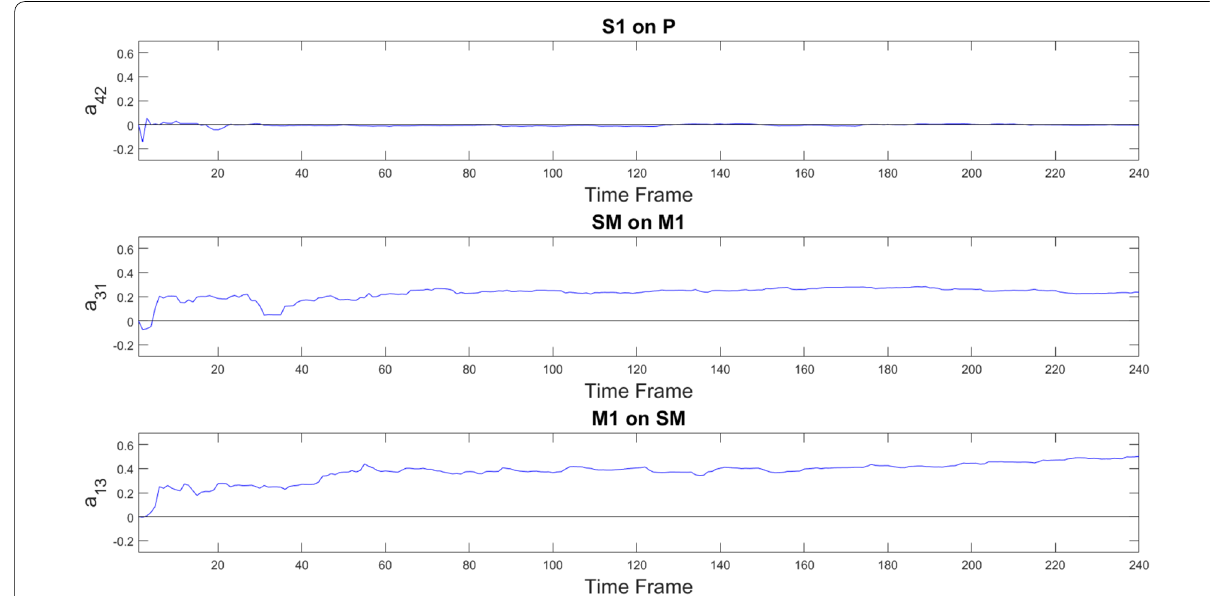
Fig. 7 Plots in blue color show the PF-estimated time courses of three representative hidden parameters a ij in the case of a 4-node motor network, estimated in real fMRI data in one subject. Top panel depicts the coefficient describing the negligible causal effect exerted by area S1 over P. Central and bottom panels represent the causal effect exerted by the SM area over M1 and viceversa